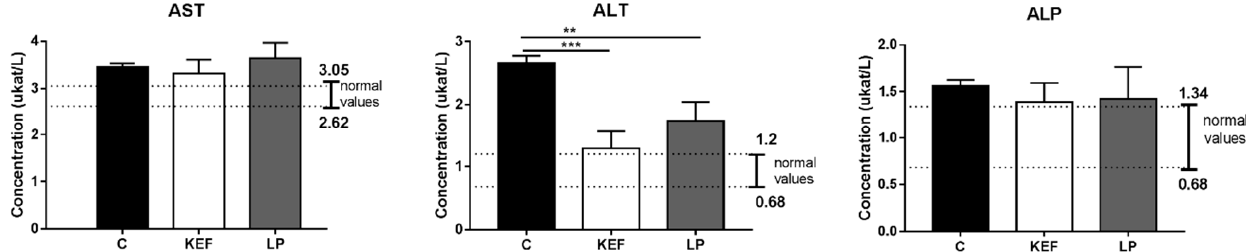
Figure 7. Effect of application of L. paracasei Ž2 and kefir on activities of serum enzymes alanine aminotransferase (ALT), aspartate aminotransferase (AST) and alkaline phosphatase (ALP) in mice ( n = 6). The ranges of recommended normal values are indicated by lines. ** p < 0.01; *** p < 0.001.